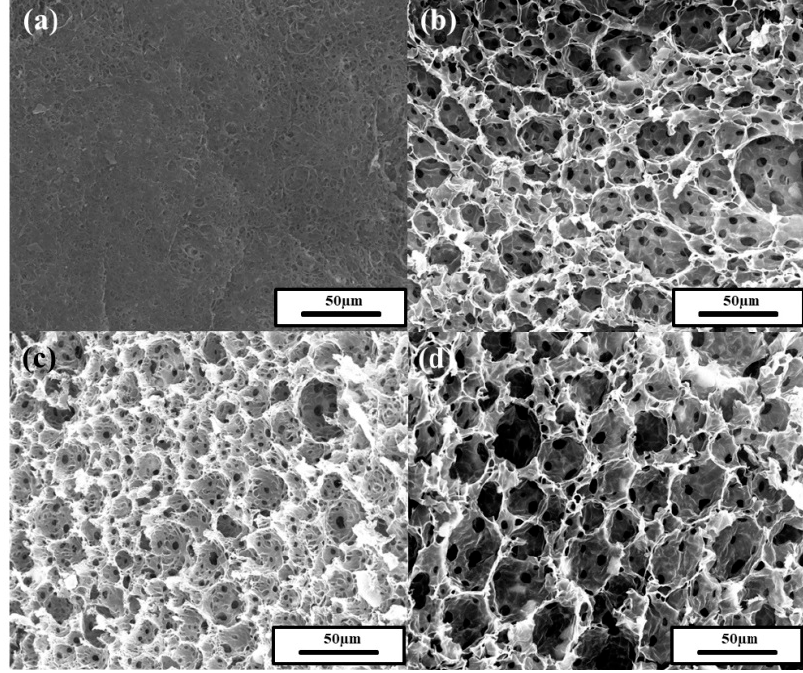
Figure 7. SEM images of polyHIPEs prepared with 6 wt.% PAAS concentration and 80 vol.% internal phase using oligoimide particle concentrations of ( a ) 0 wt.%, ( b ) 1 wt.%, ( c ) 3 wt.%, and ( d ) 5 wt.%.